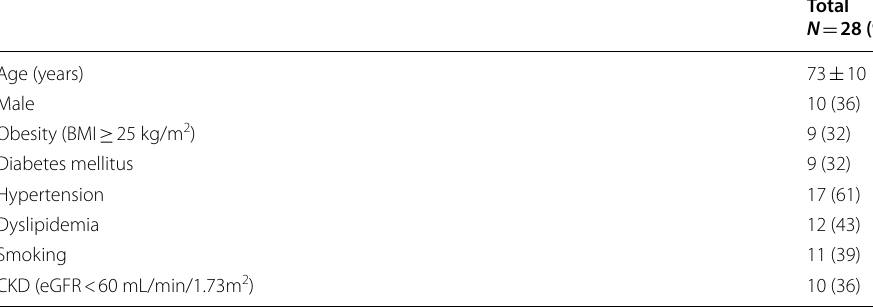
Table 1 Patient characteristics